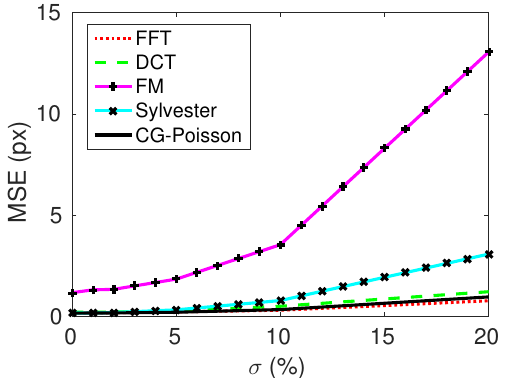
Fig. 7 MSE as a function of the standard deviation of a Gaussian noise, expressed as percentage of the maximal amplitude of the gradient, added to the gradient. FFT, DCT, and CG-Poisson methods provide the best results for different levels of Gaussian noise. The Sylvester method leads to reasonable results for a noise level lower than 10%. Since the FM approach propagates information in a single pass, it obviously also propagates errors, resulting in reduced robustness compared to all other approaches.